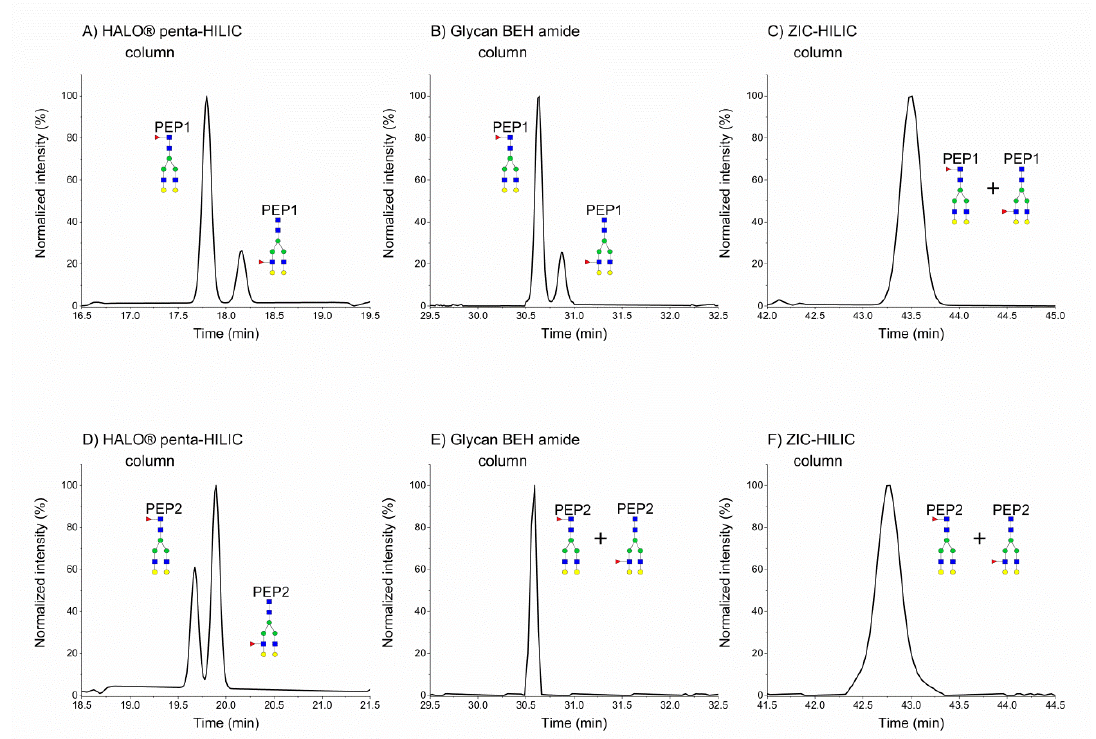
Figure 3. Normalized EIC chromatograms of A2G2F1 glycoforms of SWPAVGN 187 CSSALR ( A – C ) and ALPQPQN 453 VTSLLGCTH ( D – F ) in different HILIC columns. PEP1 refers to SWPAVGN 187 CSSALR, and PEP2 to ALPQPQN 453 VTSLLGCTH.